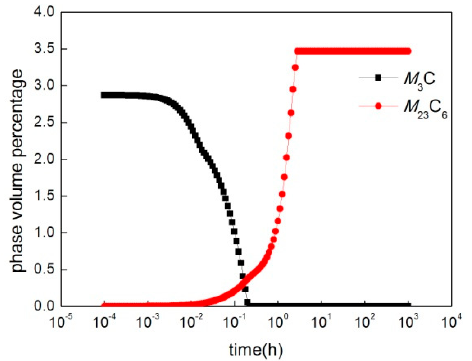
Figure 7. Simulation of the growth of M 23 C 6 simultaneously with the dissolution of M 3 C.